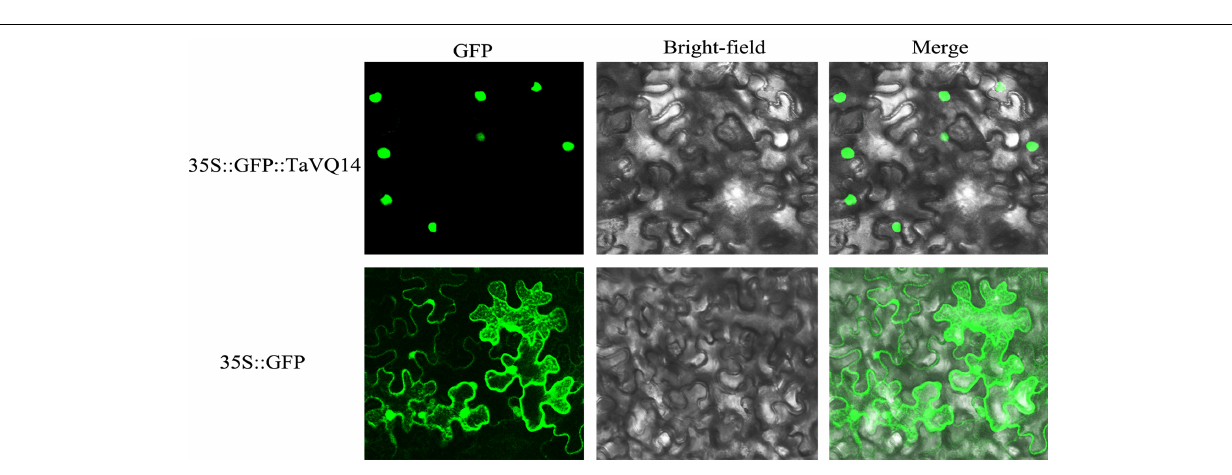
single copy material ( Supplementary Table 4 ). Transgenic